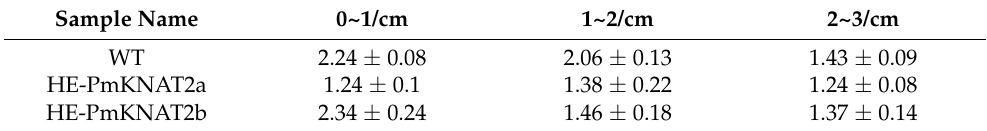
Figure 8. Effects of HE-PmKNAT2a and HE-PmKNAT2b on stems. ( A ) Comparison of longitudinal stem sections of HE-PmKNAT2a, HE-PmKNAT2b and WT. ( B ) Comparison of the stem diameters of HE-PmKNAT2a, HE-PmKNAT2b and WT. ( C ) Comparison of plant height of HE-PmKNAT2a, HE-PmKNAT2b and WT. ( D ) Comparison of the lignin content percent of HE-PmKNAT2a, HE-PmKNAT2b and WT. WT represents wild-type Arabidopsis , and HE-PmKNAT2a and HE-PmKNAT2b represent transgenic plants heterologously expressing the PmKNAT2a and PmKNAT2b genes in Arabidopsis , respectively. The letter indicates a significant change in the variance analysis ( p < 0.05). Table 4. Leaf spacing in HE-PmKNAT2 Arabidopsis compared to wild type.